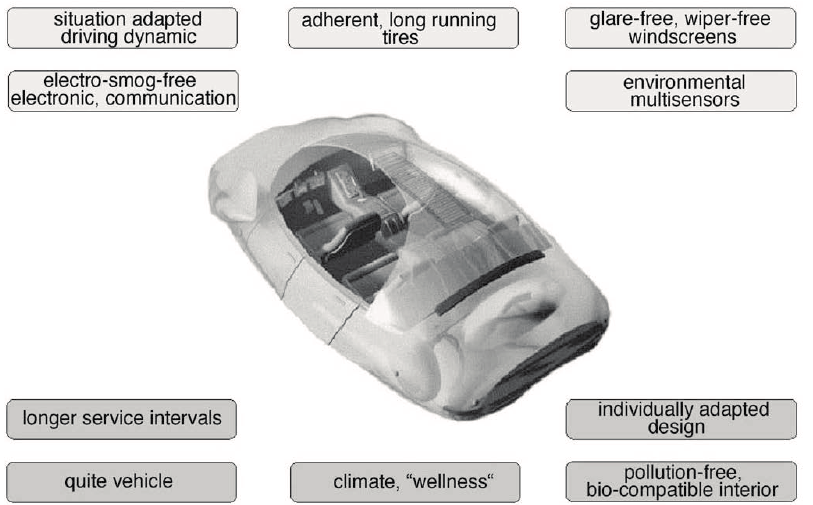
Figure 7. Customer-specific requirements to future automobiles where nanotechnology has an impact. Reprinted with permission from Elsevier, 2003 [132].